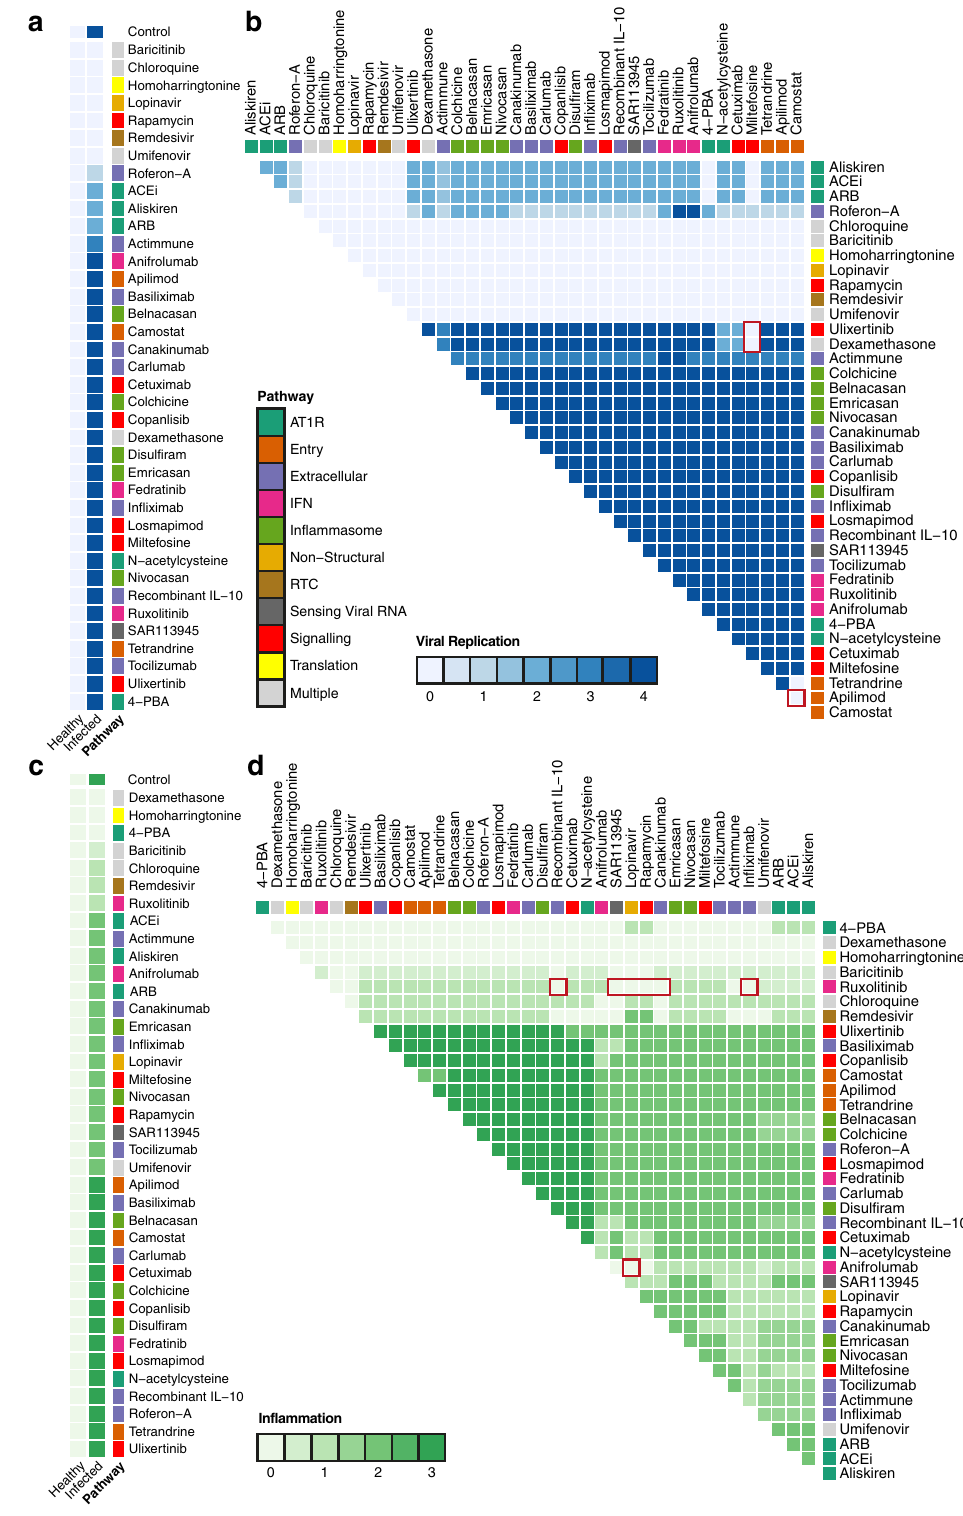
Fig. 4 In silico screens for optimised drug combinations to treat COVID-19. a Effect of single drugs (rows) on viral replication in infected cells in the early stage of severe disease and in control healthy cells. b The effects of drug combinations on viral replication in an early stage of severe COVID-19. c The effect of single drugs (rows) on in fl ammation in infected cells in a late stage of severe disease and in control healthy cells. d Effect of drug combinations on in fl ammation in the late stage of severe COVID-19. Colour of the cell corresponds to the level of viral replication (blue) and in fl ammation (green). Red boxes indicate therapies discussed in detail. The annotations show the pathway affected by each drug. Pathway categories for each node are shown in Supplementary Table